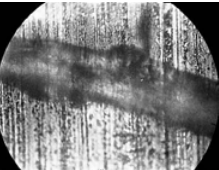
Fig 2. The bulge of coating in front of the contact zone ( ·